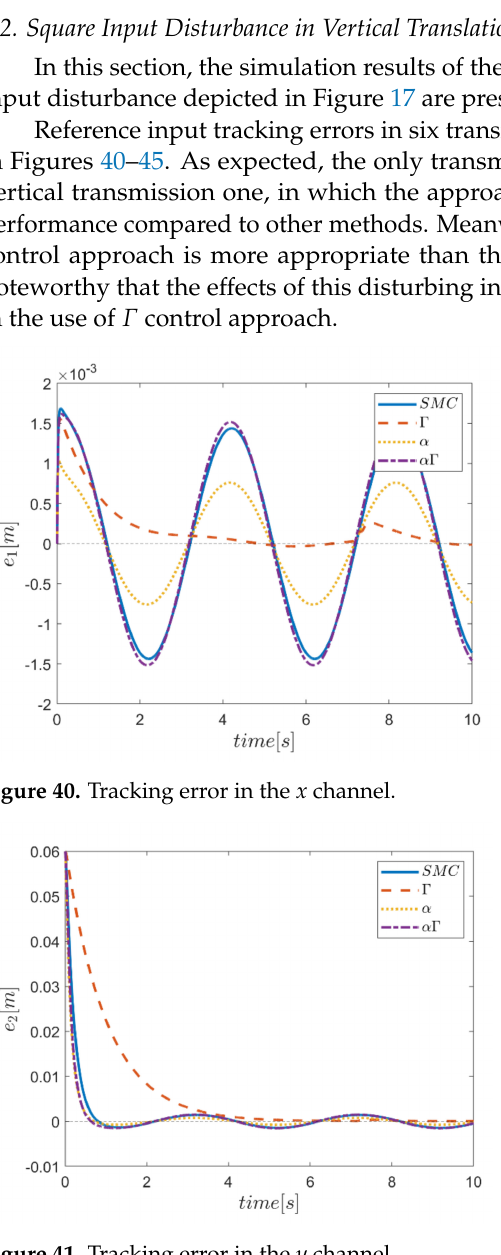
Figure 41. Tracking error in the y